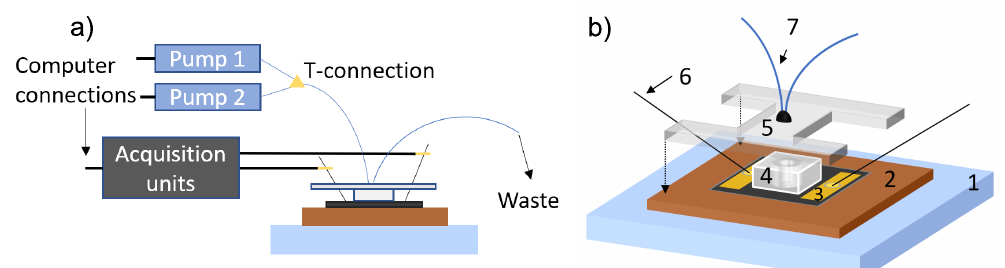
Figure 3. ( a ) Overview of the setup and all connections; ( b ) schematic of the setup with all